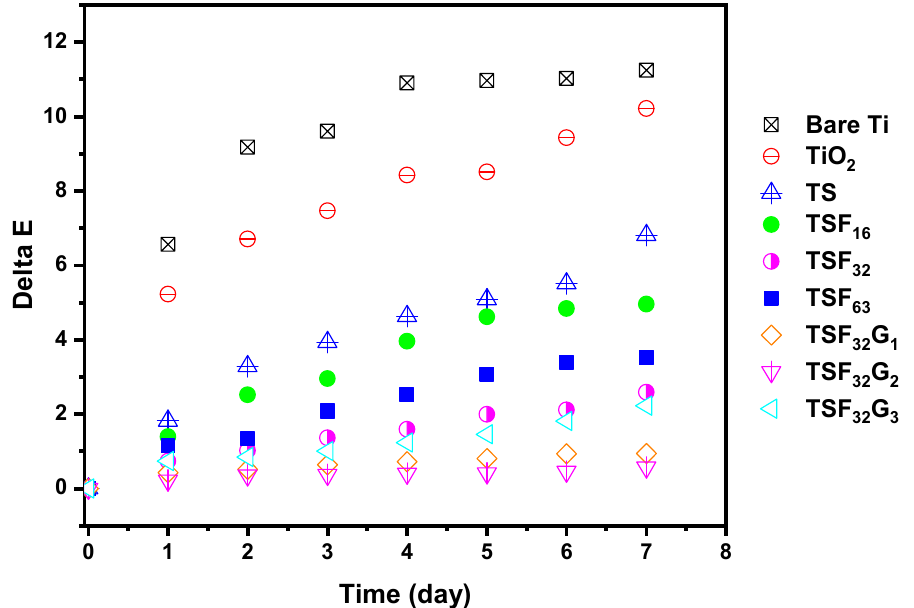
Figure 13. The discoloration test results of the bare and coated titanium specimens with the TiO 2 , TS, TSF, and TSF 32 G samples in an acid solution of pH 4 at 65 °C.